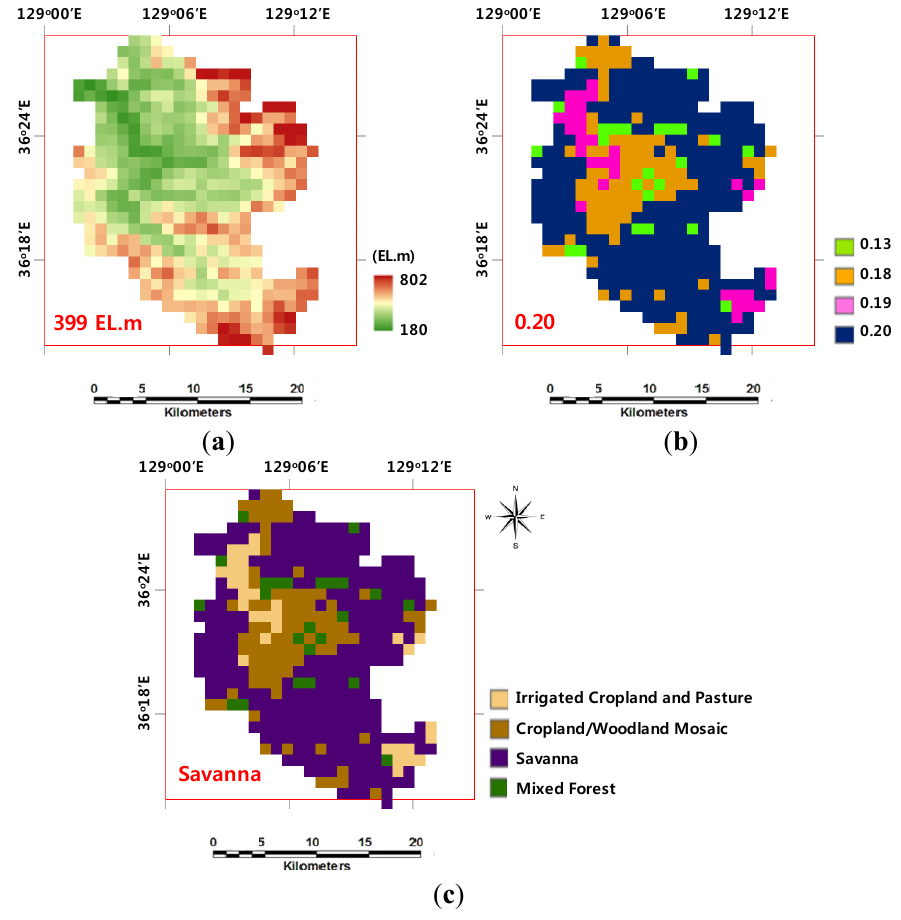
Figure 3. Spatial distributions of 1-km grids and representative values of a 30-km grid (red box and value) for ( a ) surface topography, ( b ) albedo, and ( c ) land cover category over the study